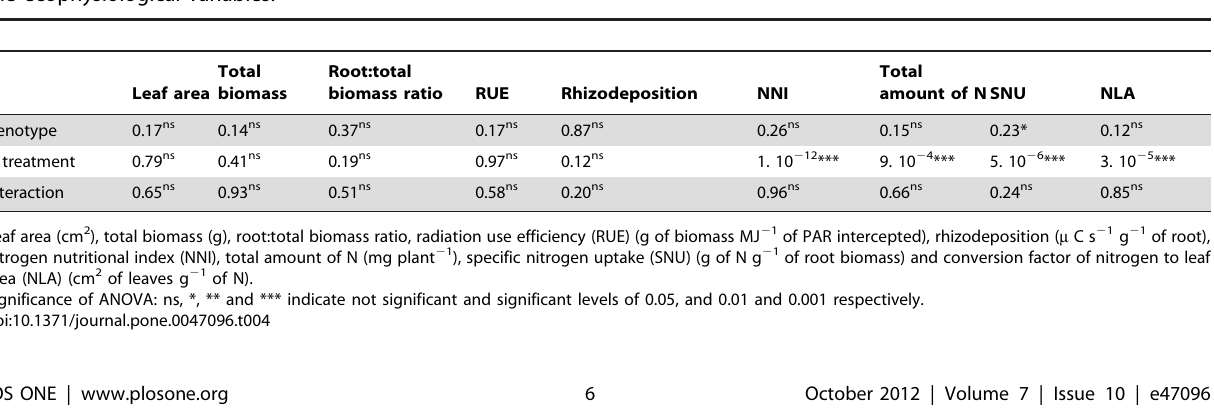
Table 4. Summary of statistical analysis (2- factor ANOVA and ANCOVA) comparing the effect of genotype and N availability on the ecophysiological variables.